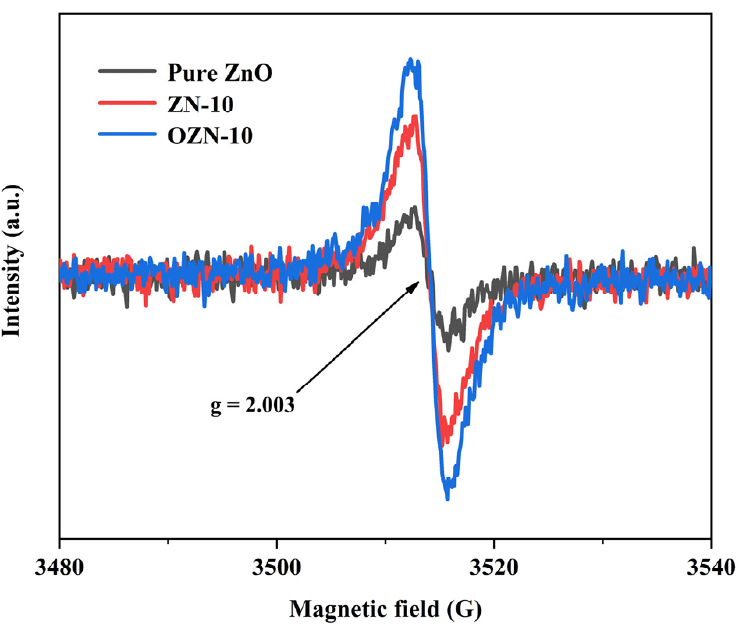
Figure 10. EPR spectra of pure ZnO, ZN-10, OZN-10. Photochemical measurements of ZnO, ZN-10 and OZN-10 were used to evaluate the electron-hole separation efficiency. Oxygen vacancy enhances visible light absorption and thus reduces the band gap. Figure 11 shows the variation of photocurrent over time for different samples at zero bias. The results show that the photocurrent of ZN-10 and OZN-10 samples is significantly stronger than that of ZnO under visible light irradiation, and the photocurrent is further enhanced with the addition of oxygen vacancy. This can be attributed to the introduction of oxygen vacancy defect levels, and the addition of effectively shortened band gap NiO to form a heterojunction, which greatly reduces the recombination of photocarriers and enhances the absorption in the visible light range. As